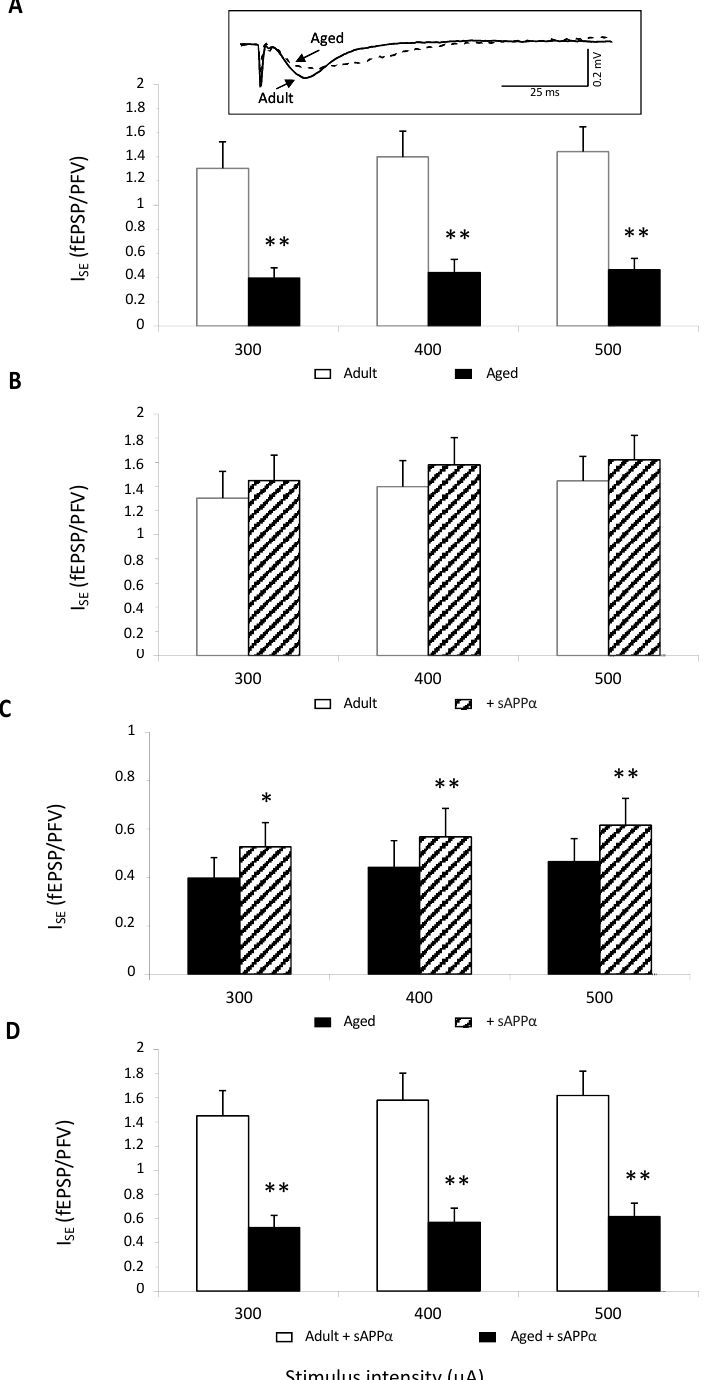
Figure 1. sAPP α (0.1 nM) improves NMDAR synaptic potentials in aged but not adult mice. ( A ) Comparison of the index of synaptic efficacy (I SE ) corresponding to the fEPSP/PFV slope ratio of NMDAR-mediated synaptic potentials plotted against current intensity in 6 adult (n = 11 slices) and 6 aged mice (n = 11 slices) (** for p < 0.01 compared to adult mice one-way ANOVA). In the insert are superimposed representative traces of NMDAR-mediated fEPSPs obtained at 400 µ A stimulation intensity. ( B ) Bar graphs illustrating the effects of sAPP α (0.1 nM) on I SE of NMDAR-mediated fEPSPs in adult mice. ( C ) Bar graphs illustrating the effects of sAPP α (0.1 nM) on I SE of NMDAR-mediated fEPSPs in aged mice (* and ** for p < 0.05 and p < 0.01, respectively, compared to control aCSF, paired t -test). ( D ) Comparison of the I SE calculated in slices from adult and aged mice plotted against current intensity in sAPP α -supplemented aCSF (** for p < 0.01 compared to adult mice one-way